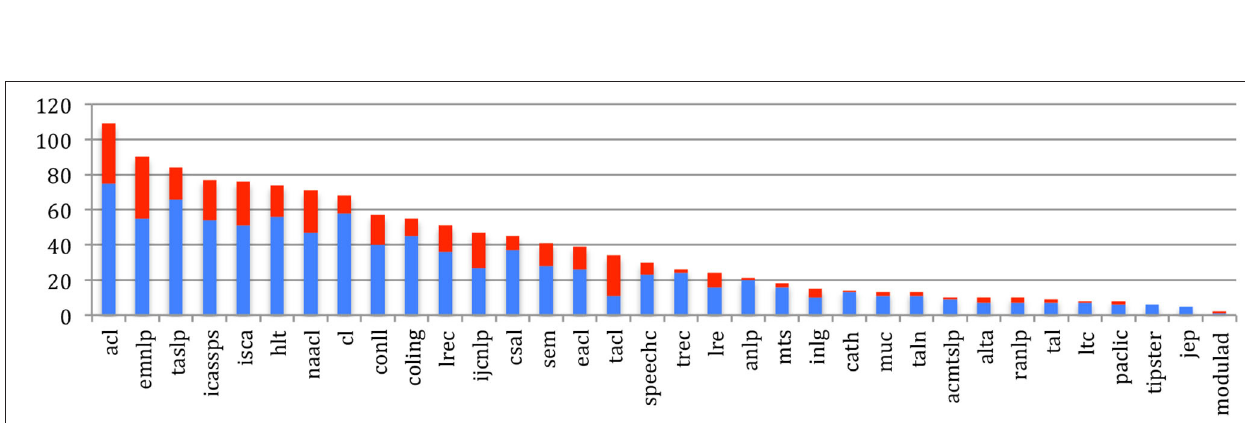
FIGURE 24 | Mean Degree of papers being cited for the 34 sources in 2015 (blue) and 2020 (red).